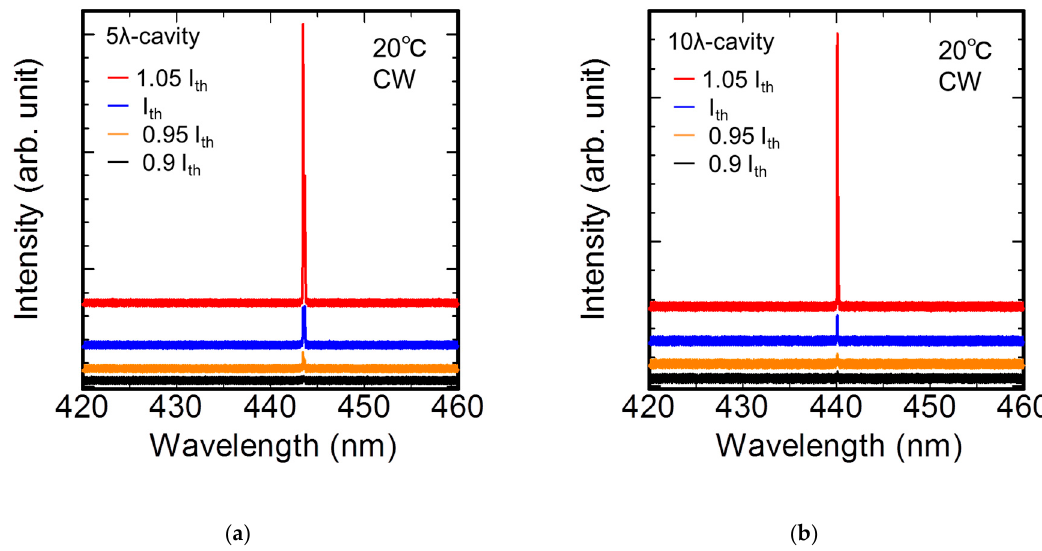
Figure 7. ( a ) Emission spectra of the VCSEL with a 5 λ -cavity structure at different injection currents. A narrow peak wavelength at 443.5 nm was observed above the threshold. ( b ) Emission spectra of the VCSEL with a 10- λ cavity structure at different injection currents. A narrow peak wavelength at 440.1 nm was observed above the threshold.